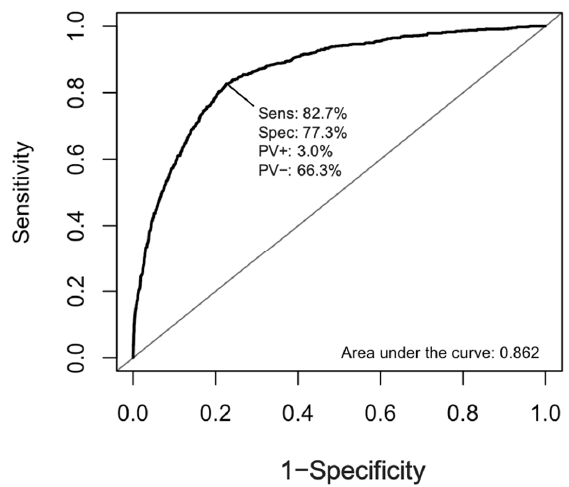
Figure 3. Receiver operating characteristic (ROC) curves for multivariable logistic regression models of risk factors for post-stroke infection.